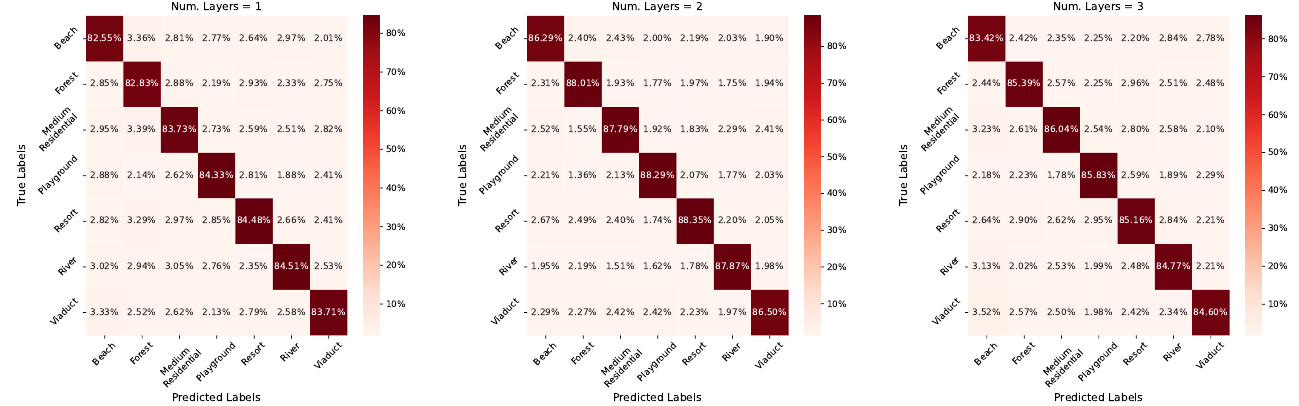
Figure 17. Confusion matrices comparison between settings using a different quantity of Bayesian edge labeling graph layers.